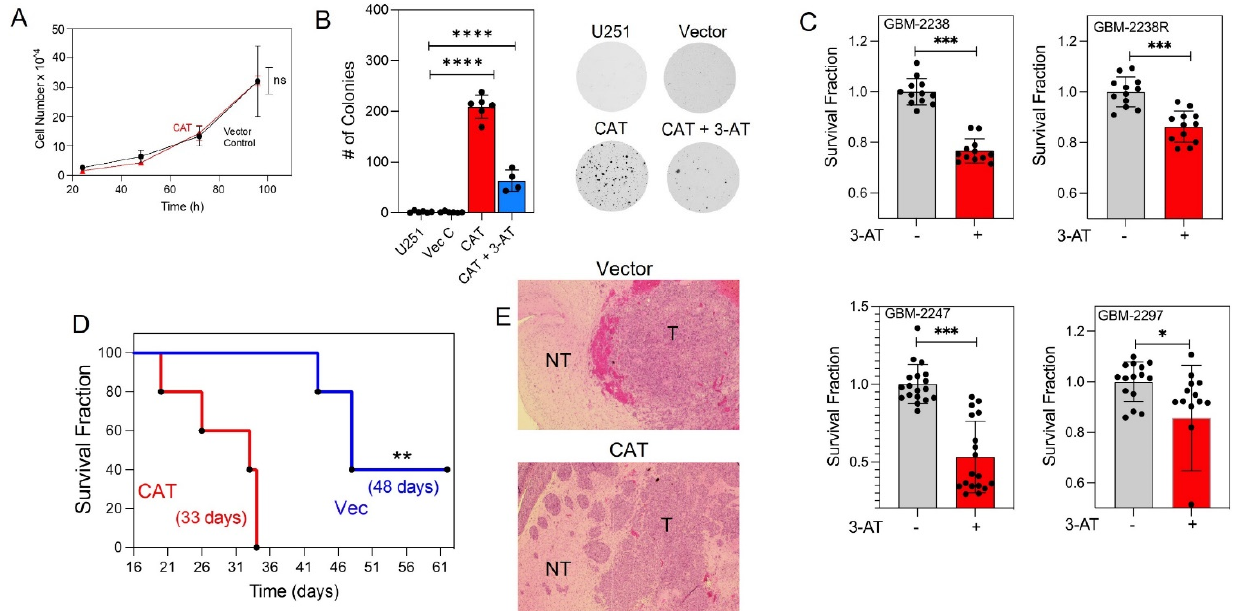
Figure 3. ( A ) Quantitative analysis of cell proliferation over time in adherent cultures of control and CAT-overexpressing U251 cells. ( B ) Quantitative analysis and representative images of anchorage-independent colony formation assays in control and CAT-overexpressing U251 cells cultured in the absence or presence of 3-AT (25 mM). ( C ) Quantitative analysis of proliferation in GSCs isolated from GBM patient biopsy samples and cultured in the presence or absence of 3-AT (25 nM). Data were pooled from three independent experiments. * p < 0.05, ** p < 0.01, *** p < 0.001, **** p < 0.0001, ANOVA. ( D ) Kaplan-Meier survival curves of overall survival in nude mice harboring orthotopic brain tumors generated by inoculation with control ( n = 5) or CAT-overexpressing ( n = 5) U251 cells (Log-rank test p = 0.0027; Wilcoxon test p = 0.0043). ( E ) Representative images of tumors resulting from intracranial implantation of vector-control and CAT-overexpressing cells and stained for Hematoxylin and Eosin. Vec, vector; T, tumor; NT, normal tissue.